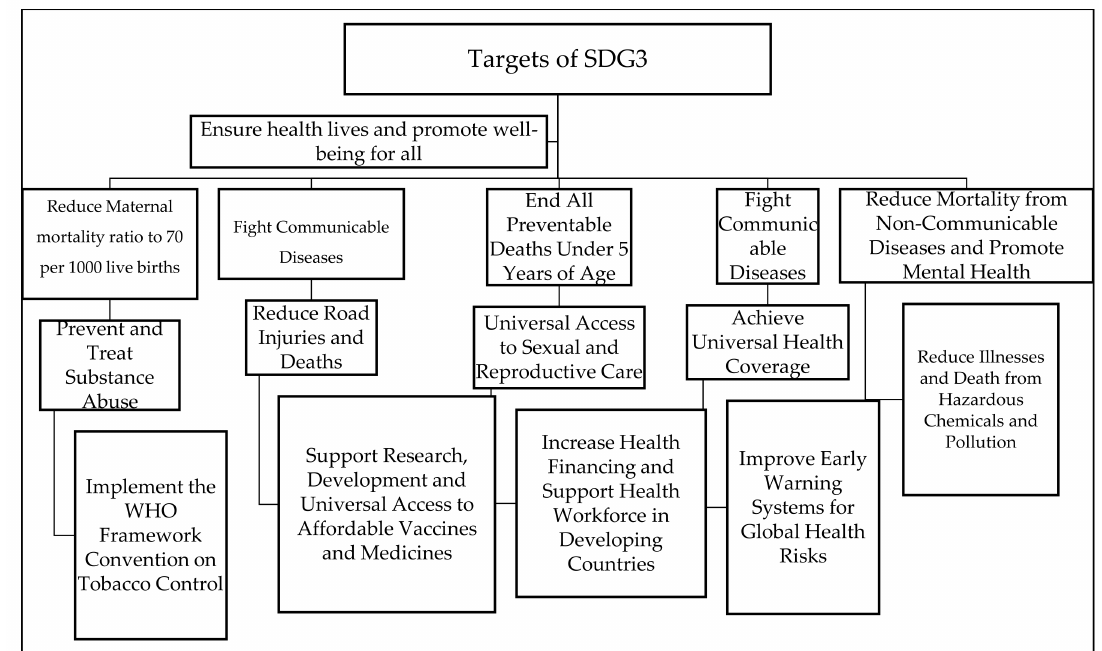
Figure 3. Targets of the Sustainable development goal 3. Source Author’s